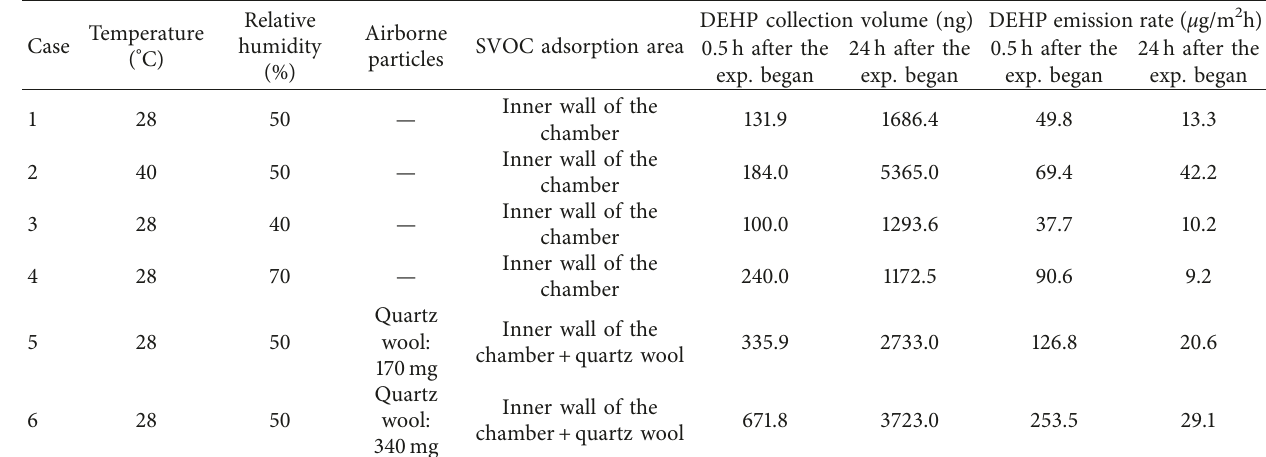
Table 6: Test results (air exchange rate � 1.5 h − 1